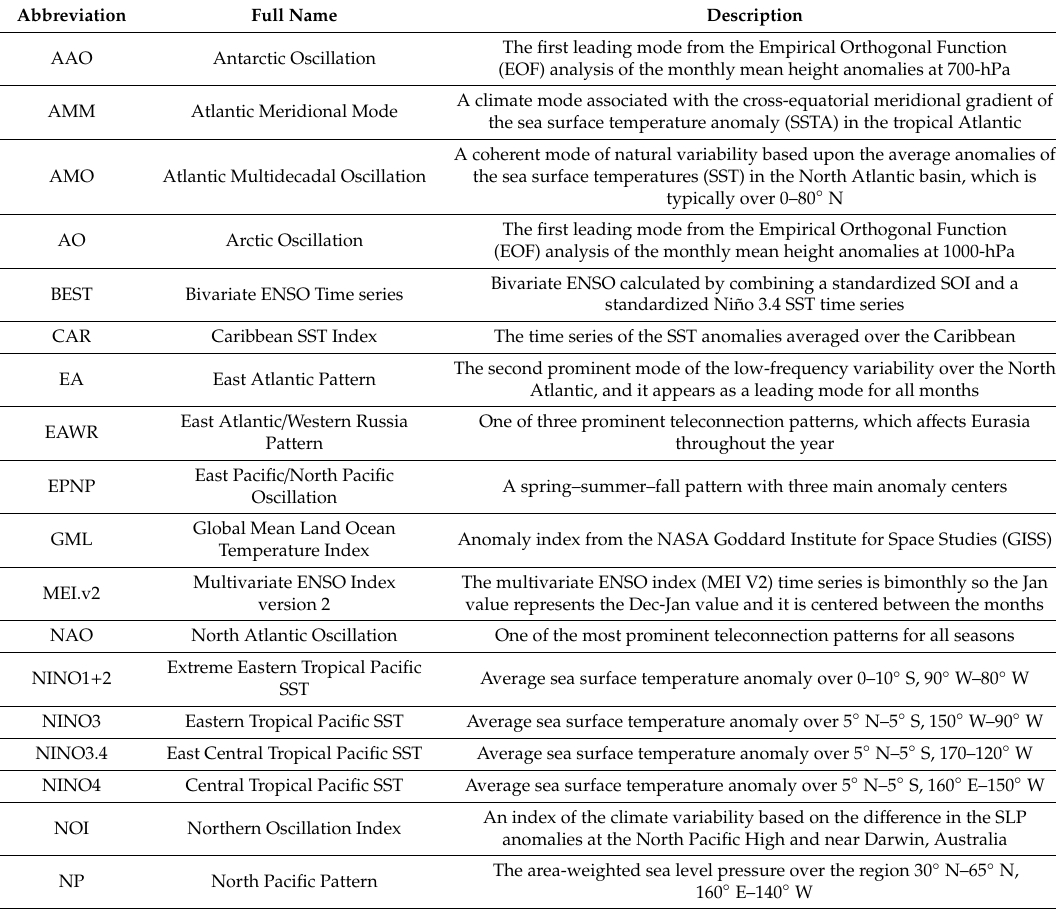
Table 1. List of climate indices used in the correlation